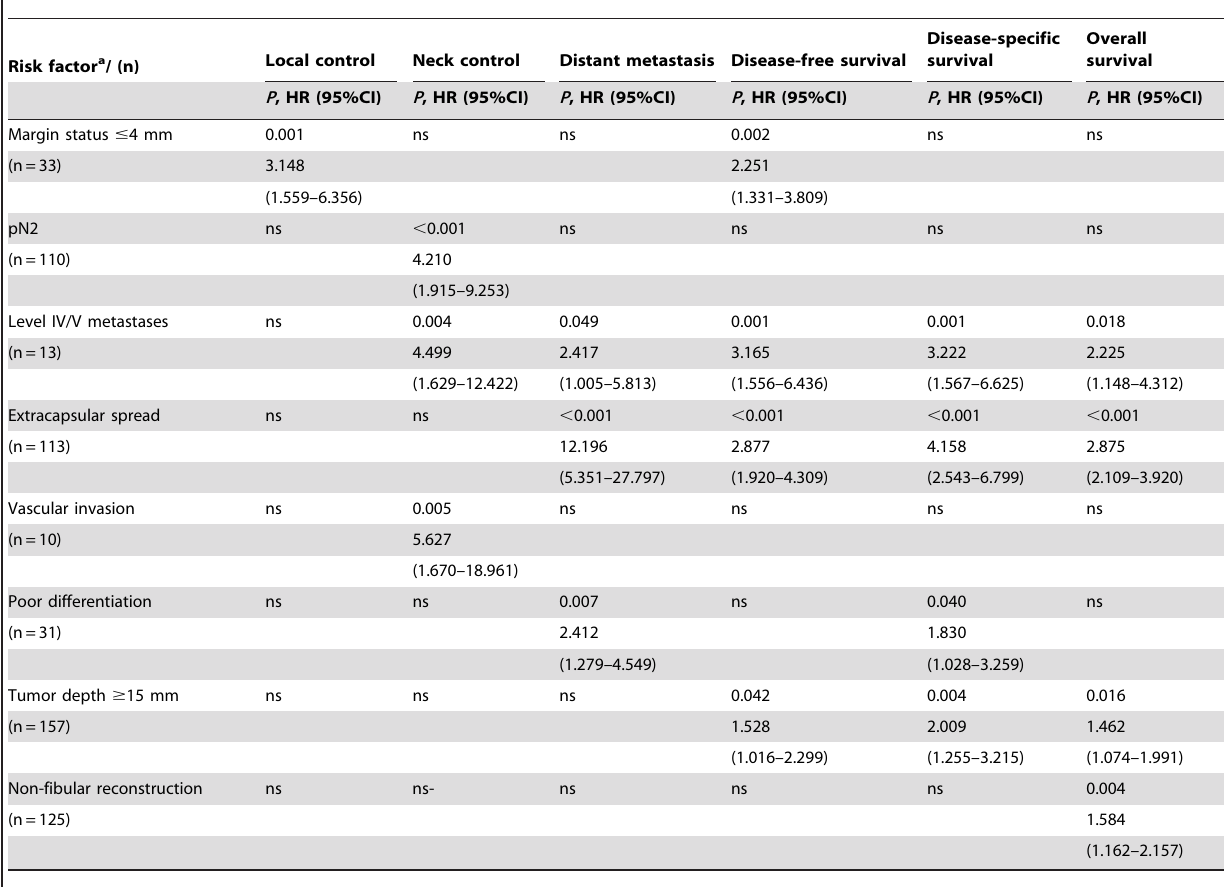
Table 2. Multivariate analysis of 5-year outcomes in patients treated by segmental mandibulectomy (n= 310).